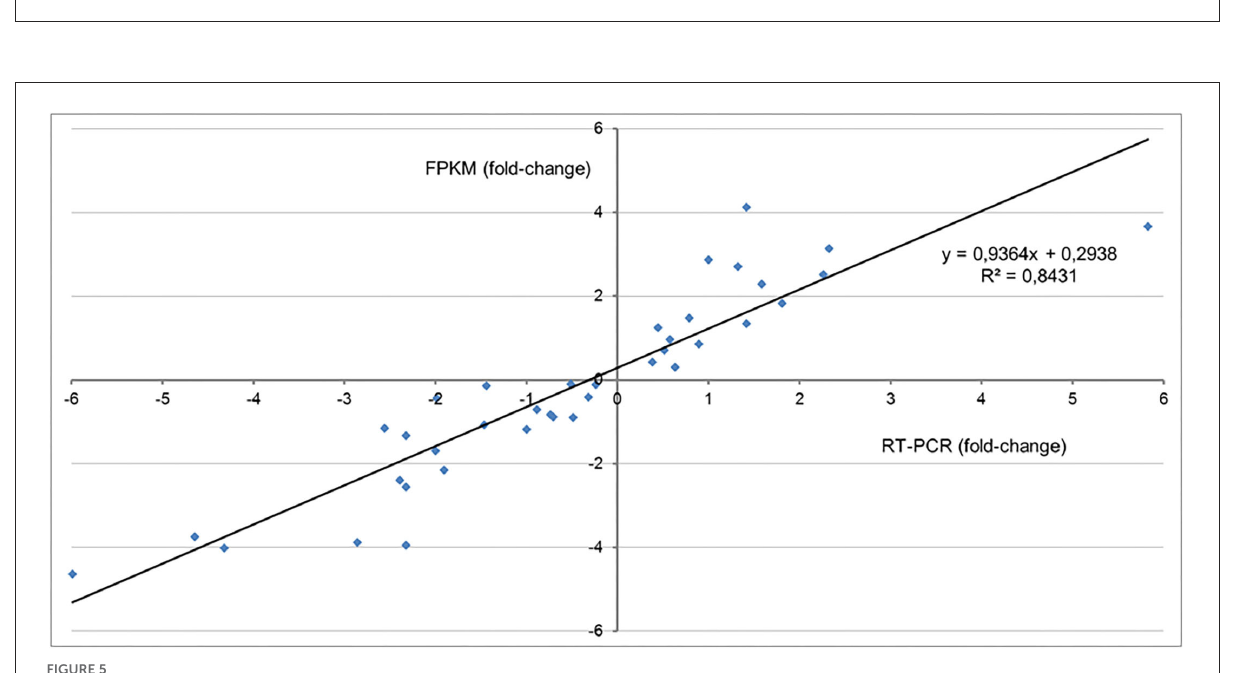
FIGURE5 Validation of RNAseq analysis. The graph displays the relationship between the changes in expression determined by RT-qPCR analysis and FPKM data from the RNA seq analysis. A correlation value of 0.8 was determined. The ratio of changes in the transcriptional level of genes comparing two fruit ripening/developmental stages was obtained from the RNAseq data [log2(FPKM)] and compared to expression data quantified by RT-qPCR analysis or data previously reported for the specie (Salvatierra et al., 2010) (For more information see Supplementary Figures 3A,B, and Supplementary Table